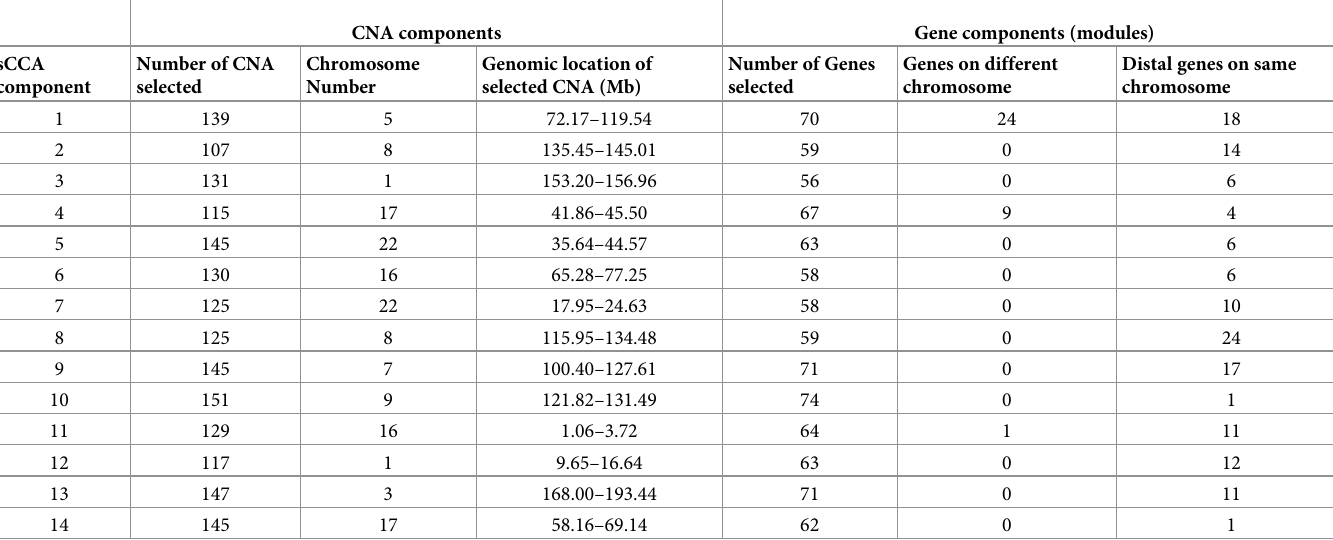
Table 1. Description of the 14 gene modules and CNA components identified through sCCA.